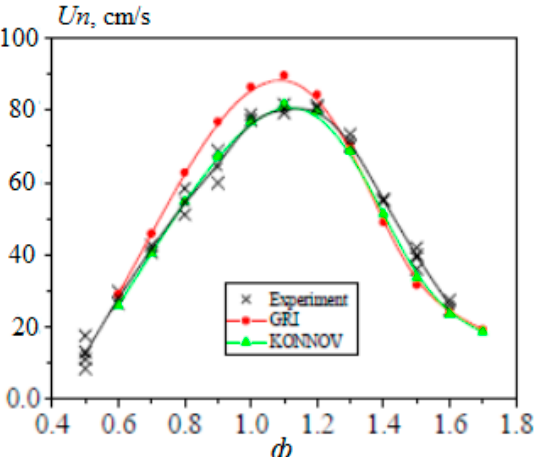
Figure 8. Comparison of the experimental (x) and calculated (•—GRI-Mech; ▲ —Konnov) depend- ences for the normal flame velocity of the methane–hydrogen–air mixture (50% H 2 ) on the equiva- lence ratio at atmospheric pressure and T 0 = 360 K (Adapted with permission from ref. [20], 2007, Prof Alexey Burluka).